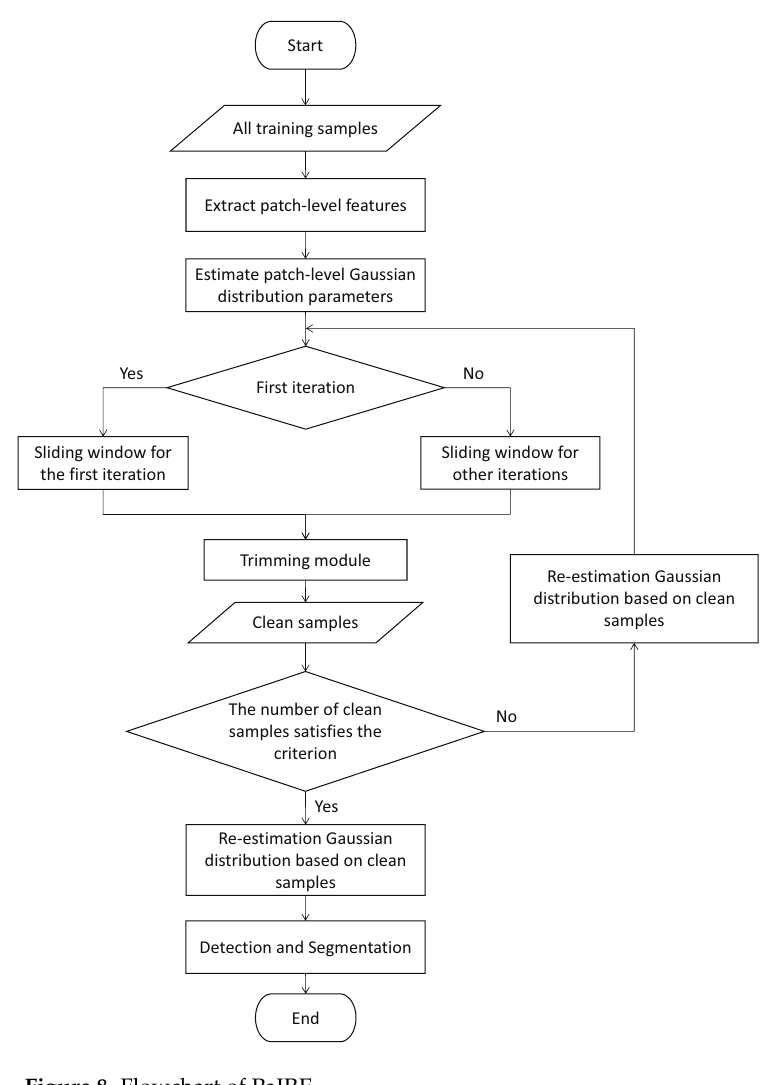
Figure 8. Flowchart of